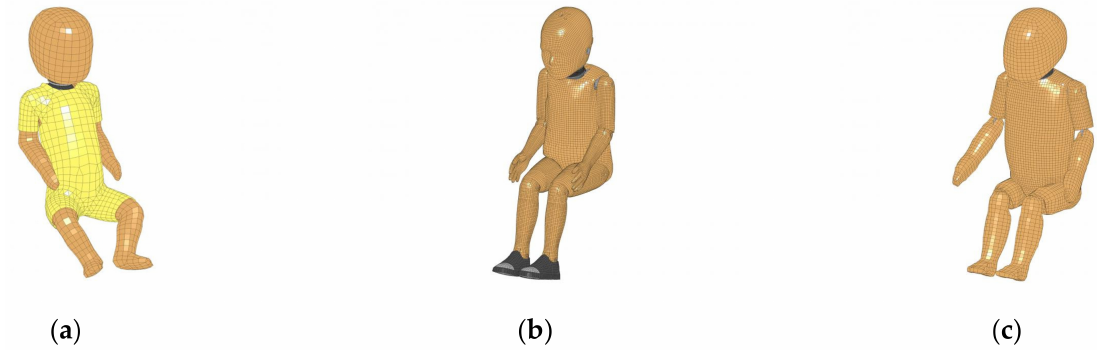
Figure 2. Children’s dummies [18]: ( a ) Seria Q FE, ( b ) Hybrid III Children Series FE, ( c ) CRABI-12MO